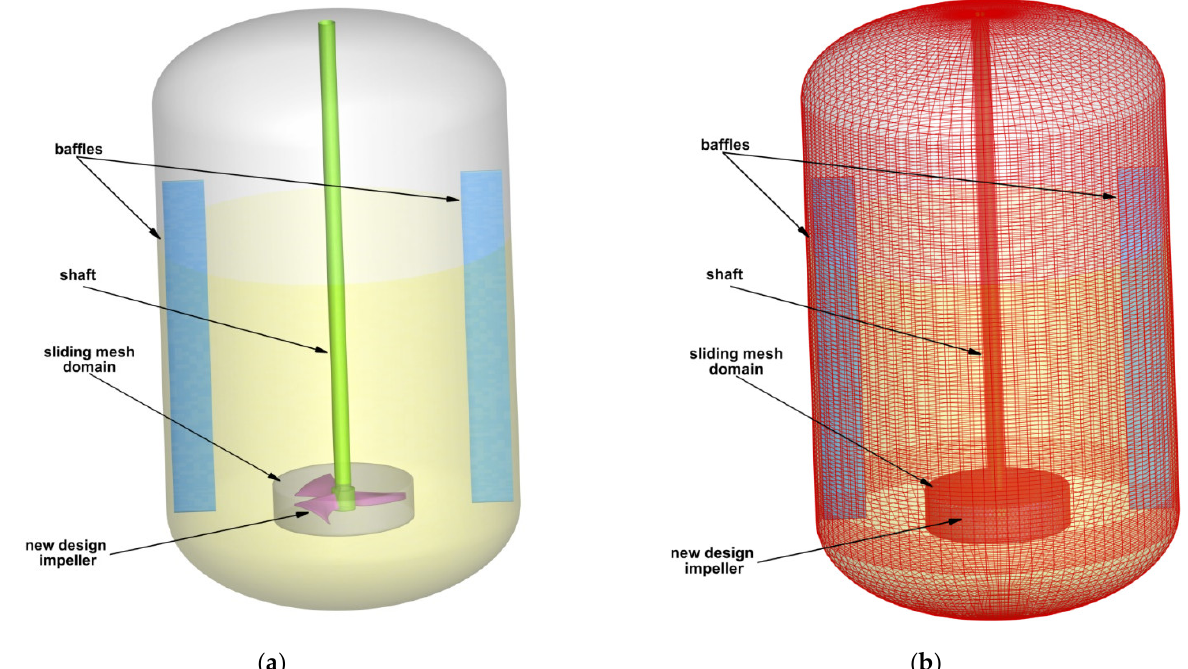
Figure 3. Computational domain: ( a ) components of the reactor; ( b ) mesh of the computational domain.